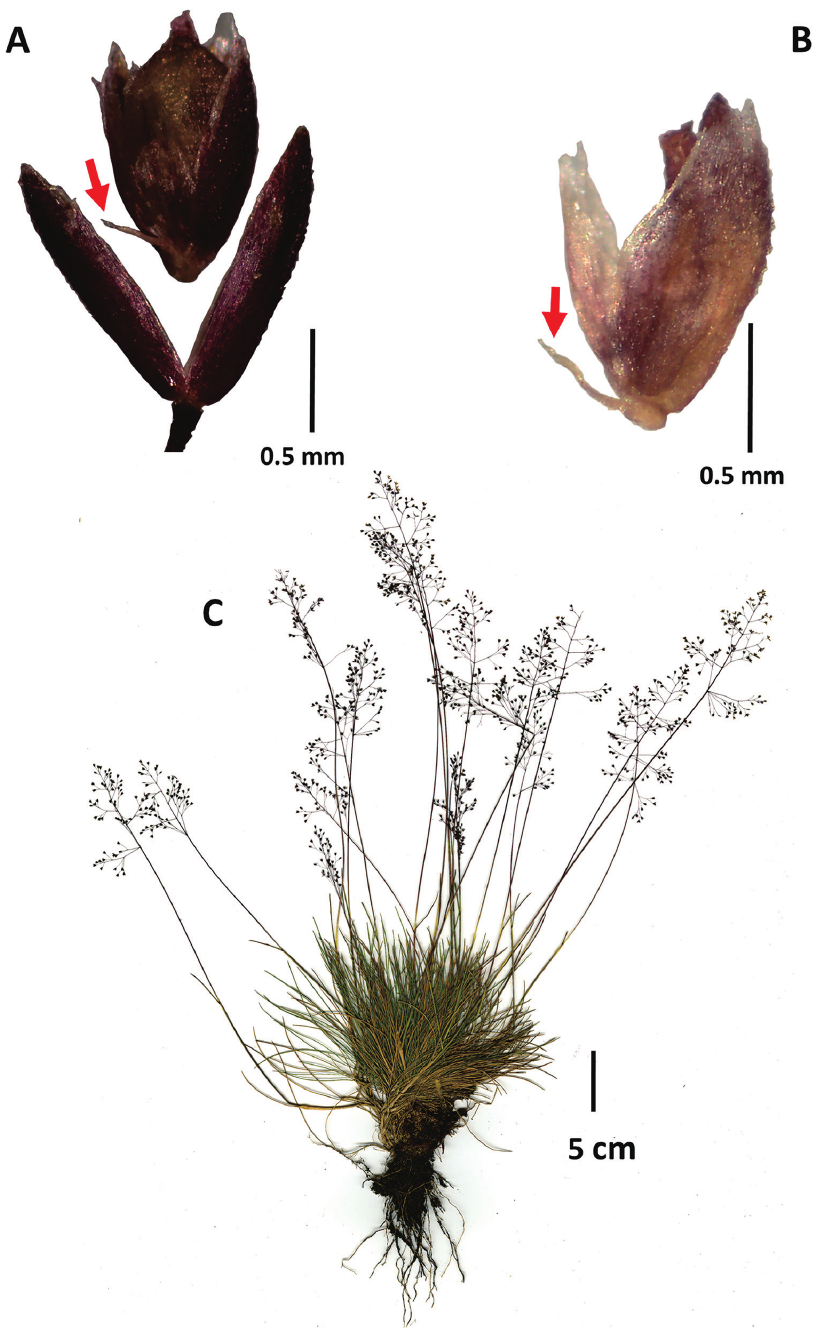
Figure 11. Podagrostis trichodes A spikelet, lateral view with floret detached and raised above the glumes, rachilla prolongation indicated by an arrow B floret, lateral view, rachilla prolongation indicated by an arrow C whole plant. Images: A , B Rodríguez (UPTC 22204), C Cuta-Alarcon 362